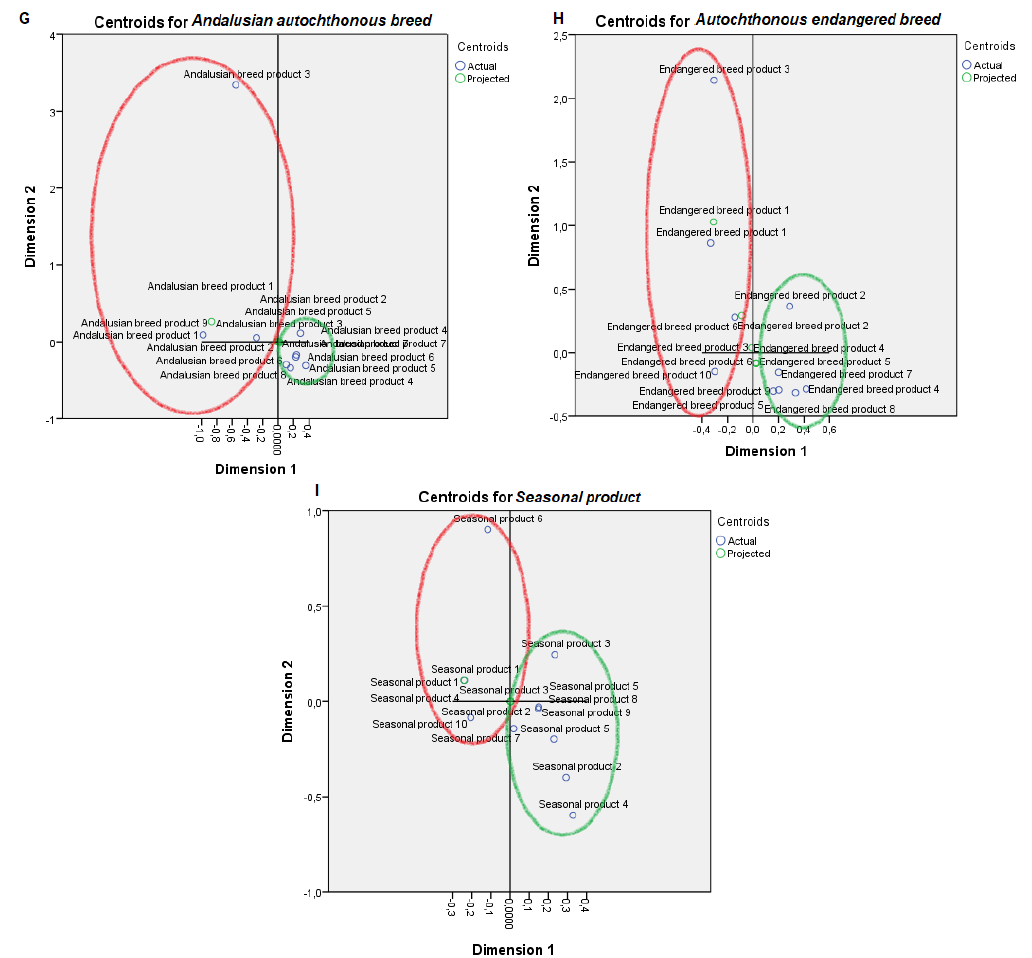
Figure 4. Object scores plot visualization of Professional Customer Profiles with regards product consciousness, egg consumption non-affine profile or PPA (red), and affine profile or PPB (green). Product consciousness was scored through: ( A ) Product closeness, ( B ) Utrerana knowledge, ( C ) Commercial egg price, ( D ) Free range price, ( E ) Ecological egg price, ( F ) Ecological product importance, ( G ) Product deriving from an Andalusian autochthonous breed, ( H ) Product deriving from an autochthonous endangered breed and ( I ) Product having a seasonal nature.